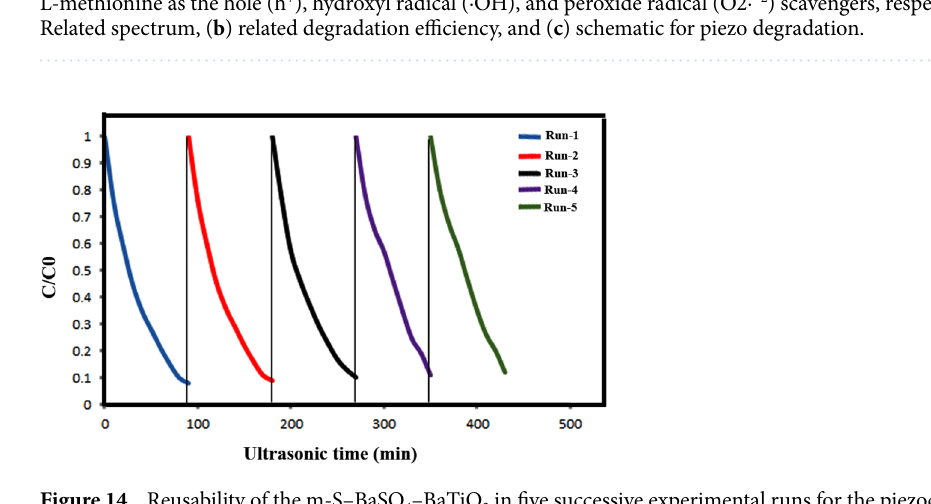
Figure 14. Reusability of the m-S–BaSO 4 –BaTiO 3 in five successive experimental runs for the piezocatalytic degradation of AB113 in aqueous solution under ultrasonic